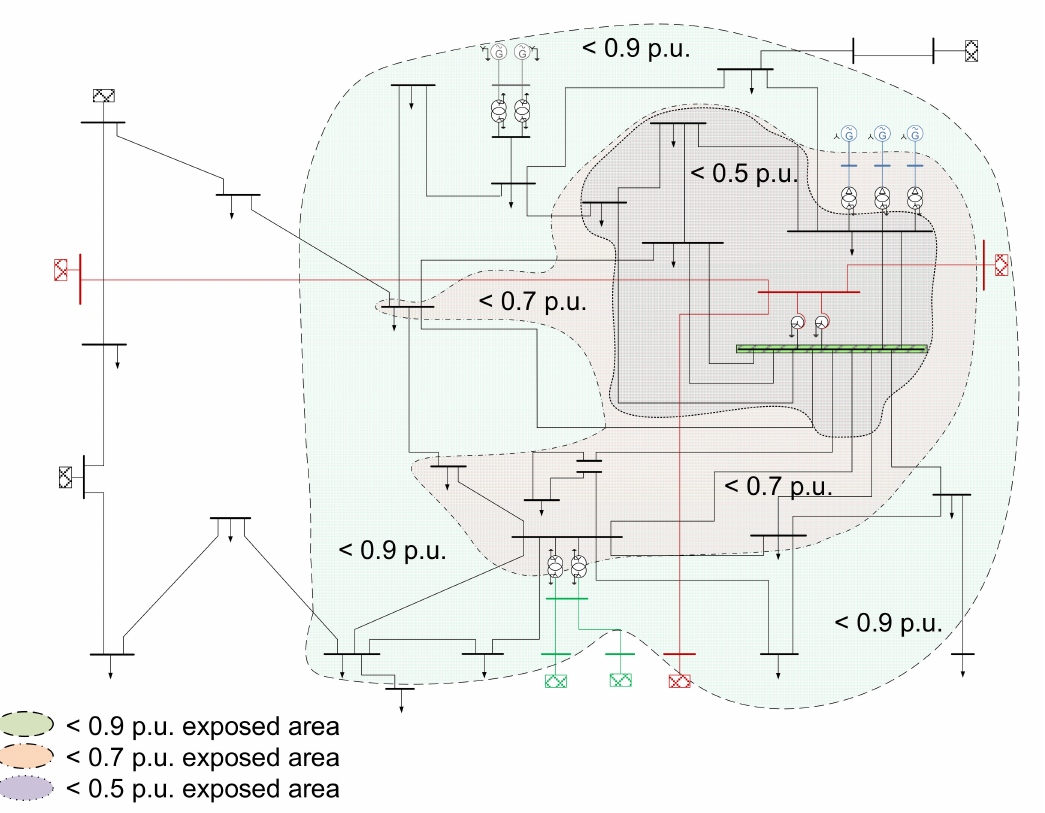
Figure 1. The exposed area of bus 2 for voltage thresholds of 0.5, 0.7 and 0.9